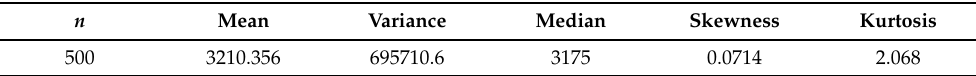
Table 3. Descriptive statistics for the variable b.weight.